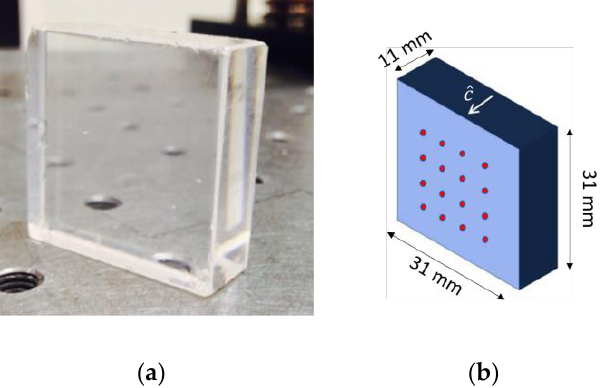
Figure 1. ( a ) the typical PWO sample ( b ) the scheme of the sample geometry and the area on which the laser pulses are shot (red dots). The dots indicate the points where the pulsing laser impinges. The arrow is representing the 𝑐̂ axis direction.